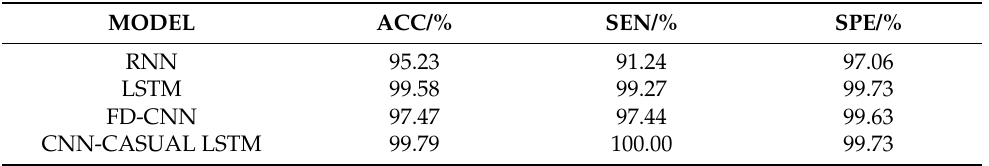
Table 2. Classification accuracy, sensitivity, and specificity of comparative experiments on SisFall data set.